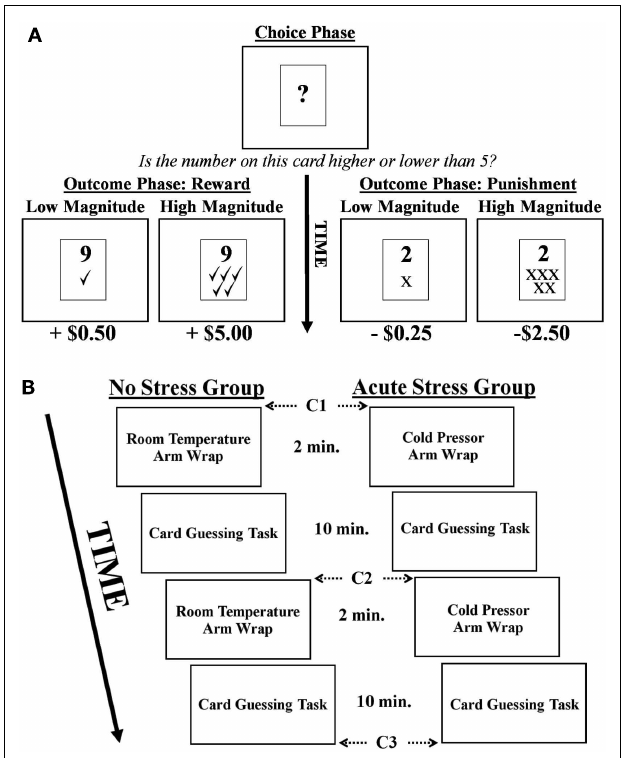
FIGURE 1 | (A) Depiction of the card guessing task. Note, in the example above a correct choice would be “higher than five.” (B) Experimental timeline and cortisol sampling schedule (C = cortisol